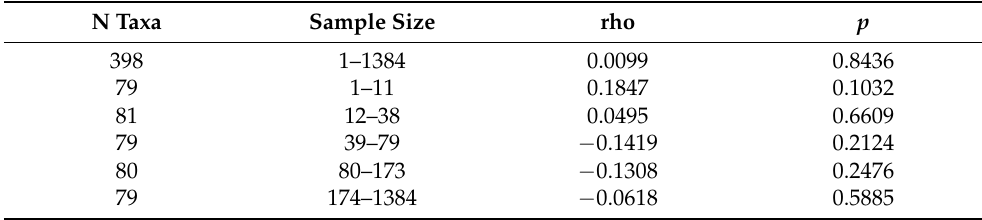
Table 1. Host body mass did not correlate with louse genus richness across hummingbird taxa (Spearman rank correlations). First, we tested the whole sample of 398 taxa. Then, to control for sample size (the number of individuals in each taxa) effects, we classified the 398 taxa into 5 classes of different sample size categories (5 ‘layers’). No significant body mass effect was detected in the whole sample or any of the 5 classes. N